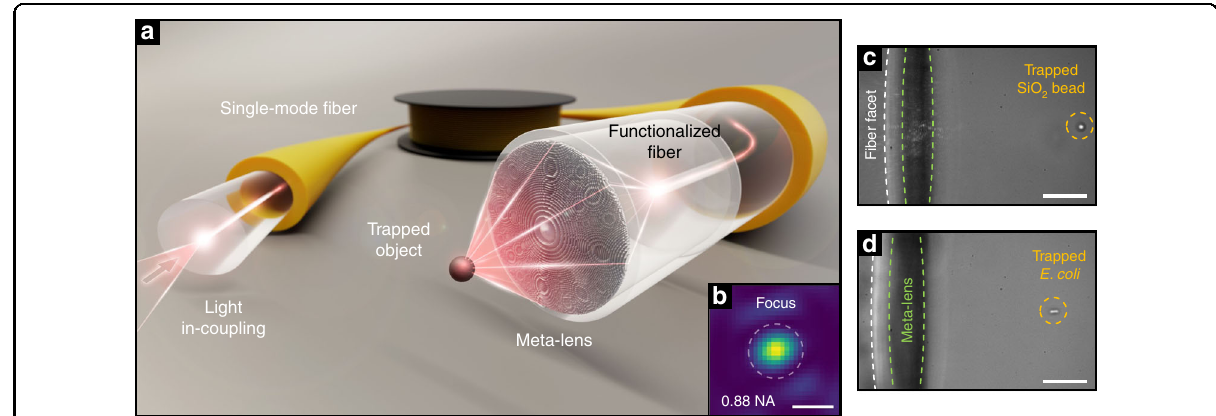
Fig. 1 Principle of an ultra-high NA meta- fi bre for fl exible optical trapping. a Illustration of the device including a 3D nanoprinted meta-lens located on the tip of an optical fi bre to trap particles. b Example of a measured radial focal plane in water (scale bar: 500 nm, wavelength of 660 nm, the dashed line indicates the width of the fi tted Airy function). c Micrograph of a 2 µm silica bead and ( d ) an Escherichia coli ( E. coli ) bacterium optically trapped with a single fi bre UNM in water imaged from the side (scale bars 15